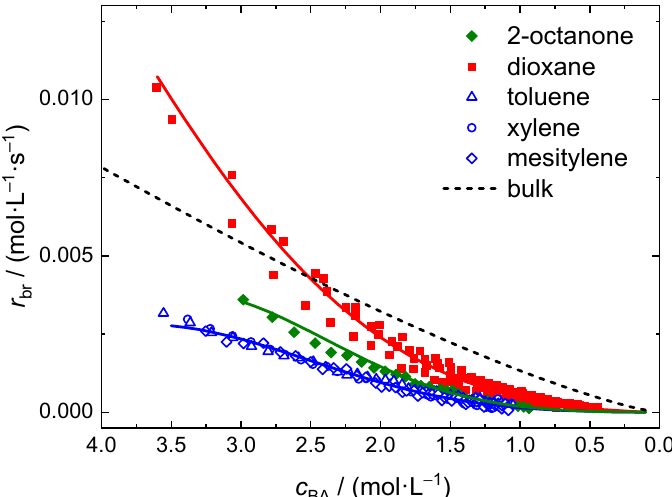
Figure 8. r br data obtained for polymerizations at 130 °C in the indicated solvents with x BA = 0.5. The full lines were calculated according to Equation (13) with the parameter set given in Table 5 and the dashed line with Equation (6) and parameters from Table 1. Table 5. Estimated coefficients a 01 , a 3 , and a 4 of the model represented by Equation (13) for polymerizations in the indicated solvents with equimolar amounts of monomer and solvent at 130 °C. a 2 was set to 1.28.